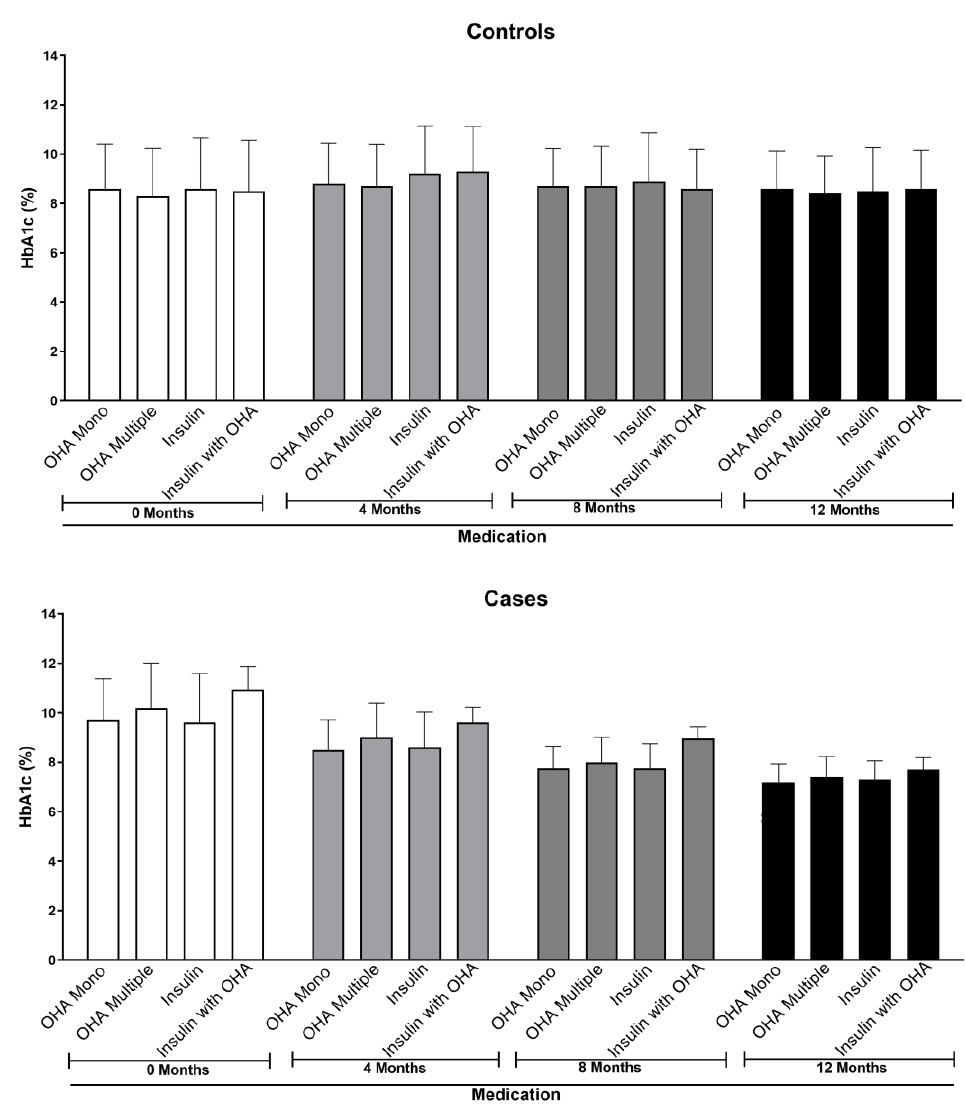
Figure 3. Use of anti-hyperglycemic agents and intervention through phone call-based education on HbA1C variations among the study participants. Phone call-based education assisted in reducing the HbA1C in diabetics as evidenced by a visible decrease in the HbA1C only in participants in the case group compared with the ones in the control group. The observed differences in the case group compared with baseline HbA1C were significant, especially the OHA, OHA — multiple, and insulin categories at 4, 8 & 12 Months ( p < 0.05; One- Way ANOVA, Tukey’s multiple comparison test). However, the insulin and OHA group showed a significant difference only at the 12 month period.